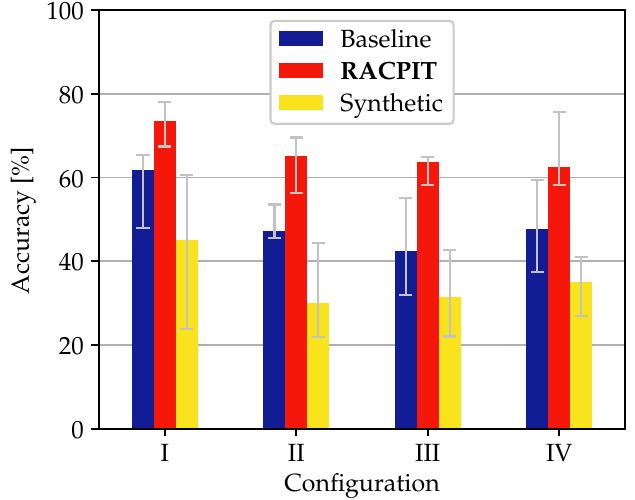
Figure 9. Experiment results. Each bar represents the median value out of five experiments, with the error bars indicating the minimum and maximum observed value. Besides the accuracy for the baseline and RACPIT, we also present the obtained accuracy when we directly feed synthetic data to the baseline.